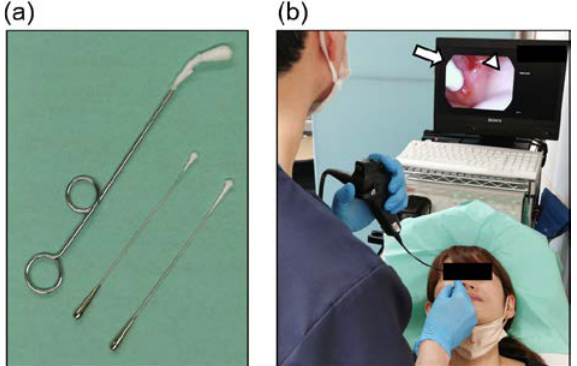
Figure 1. Epipharyngeal abrasive therapy (EAT). ( a ) Cotton swabs for EAT. ( b ) The method of endoscopic EAT. The entire epipharyngeal wall is scrubbed using a sterile straight nasal cotton swab soaked in 0.5% ZnCl 2 solution. The white arrow indicates a sterile straight nasal cotton swab. The white triangle indicates impure bleeding.